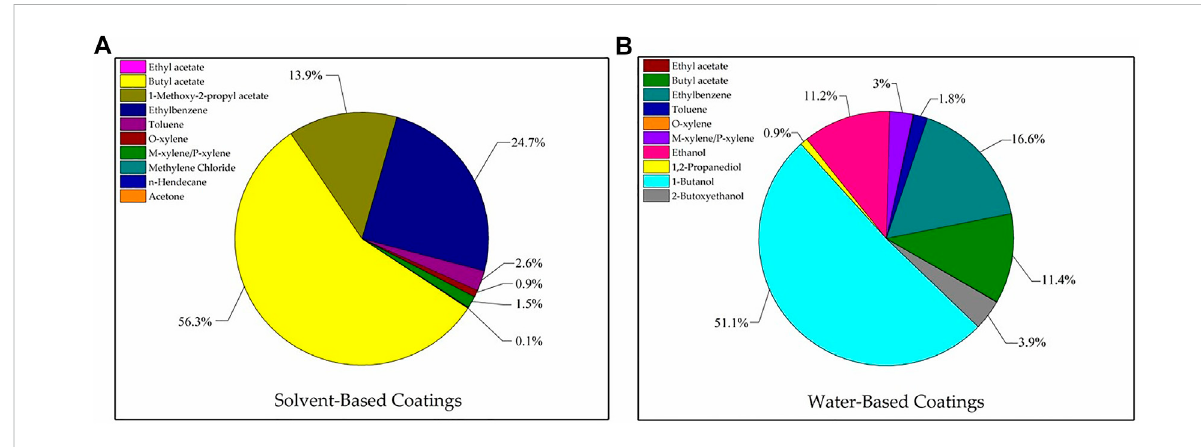
FIGURE 5 Odor contribution of VOCs emitted from solvent-based coatings (A) and water-based coatings (B)